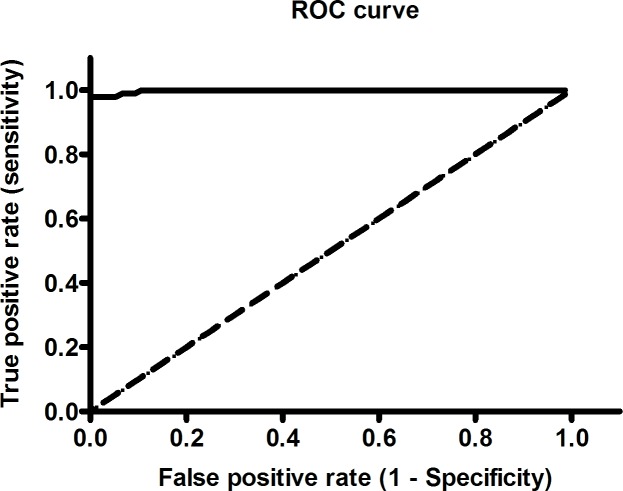
Receiver operator characteristics (ROC) curve for urine ELISA.ROC curve obtained from the ELISA values for the detection of anti-Leishmania IgG antibodies in urine samples. Cut-off value (0.1875), sensitivity (97.94%), specificity (100%) and AUC (0.9984) were determined by this curve using GraphPad Prism software (version 5.0).